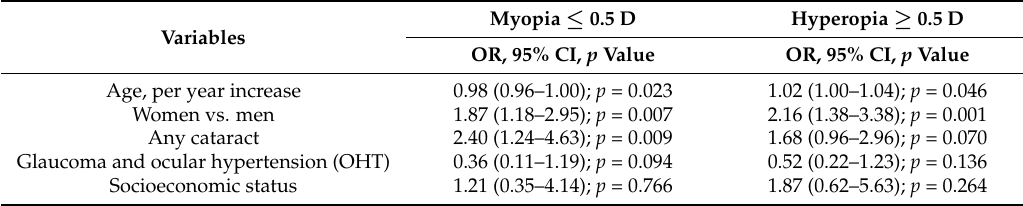
Table 3. Multiple logistic regression models of the risk factors for myopia and hyperopia.